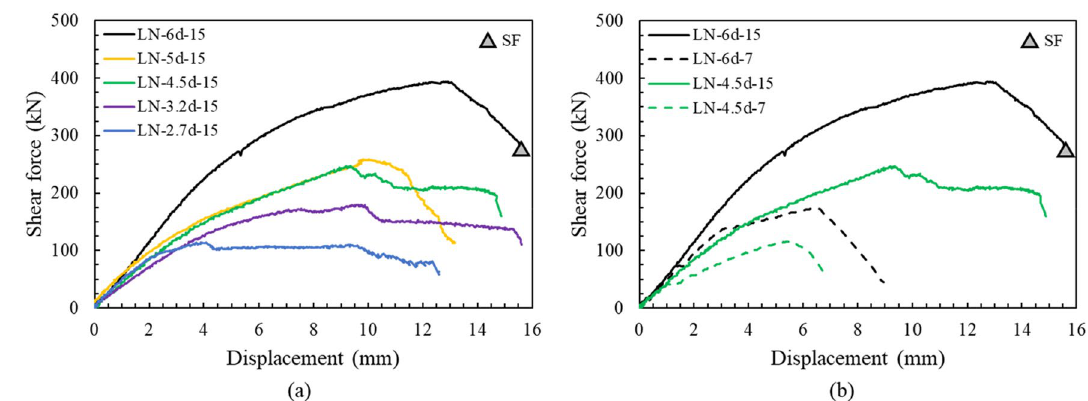
Figure 7. Load–displacement curve, edge distance: ( a ) embedment depth of 150 mm, ( b ) embedment depth of 70